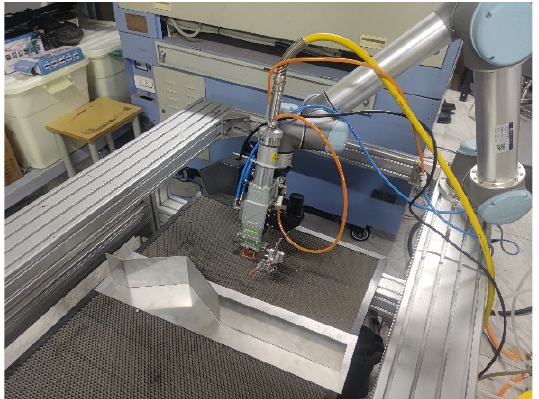
Figure 16. The experimental platform.